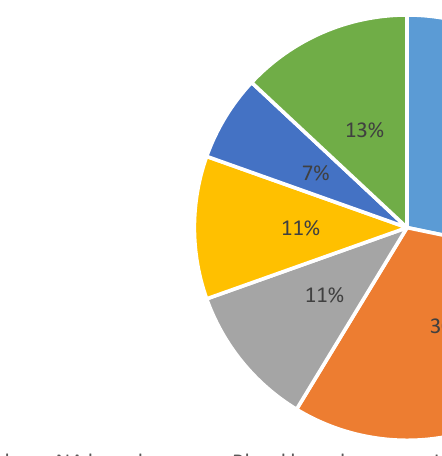
Figure 1. Distribution of topics covered by papers (total of 46) published within the theme of lab-on-a-disc in 2015.